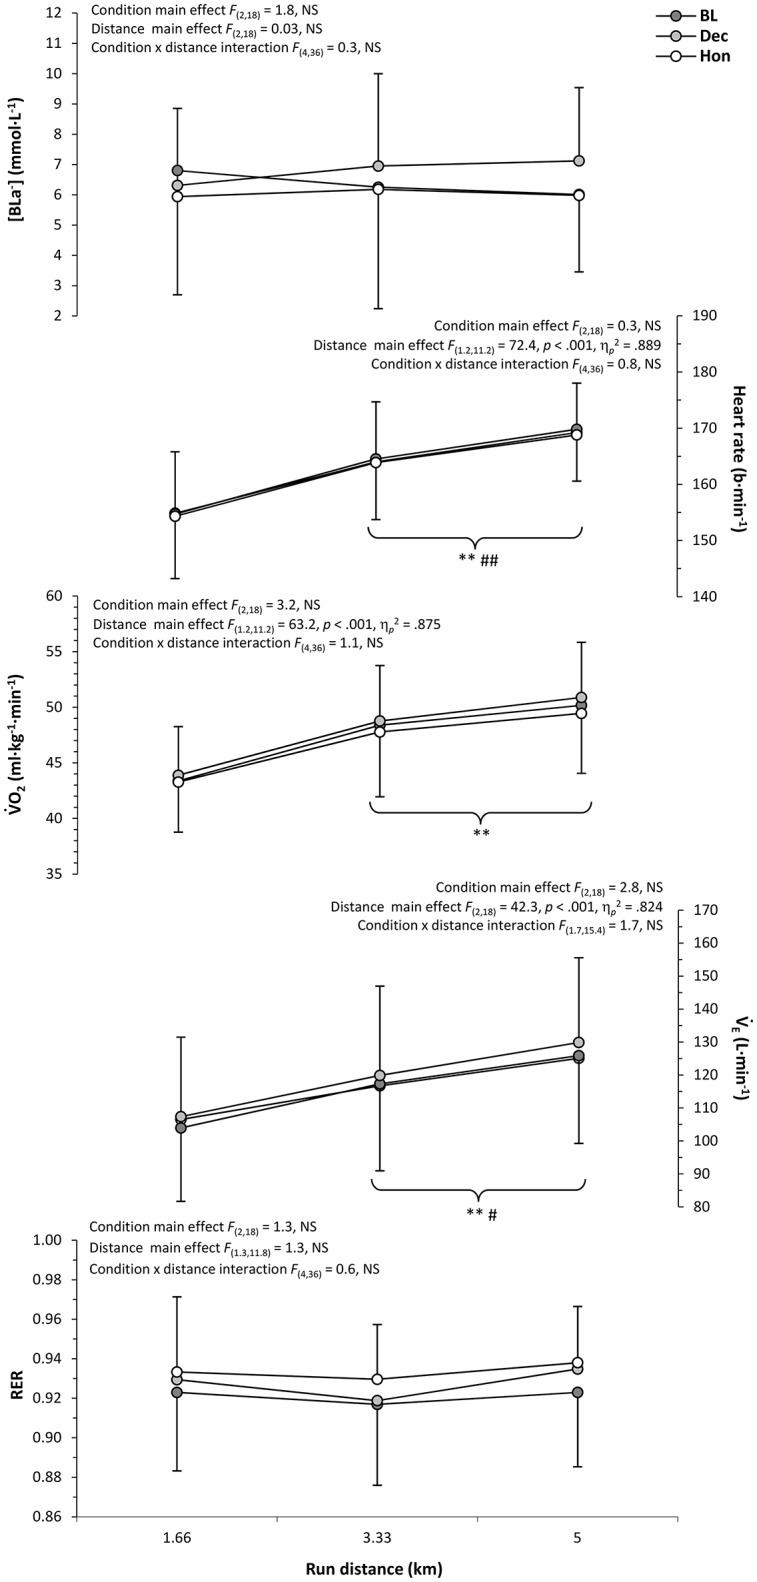
Mean ± SD physiological responses for each 1.66 km run section. Significantly different from; initial value, **p < 0.01; previous value, #p < 0.05, ##p < 0.01 (parentheses indicate significance in all conditions).